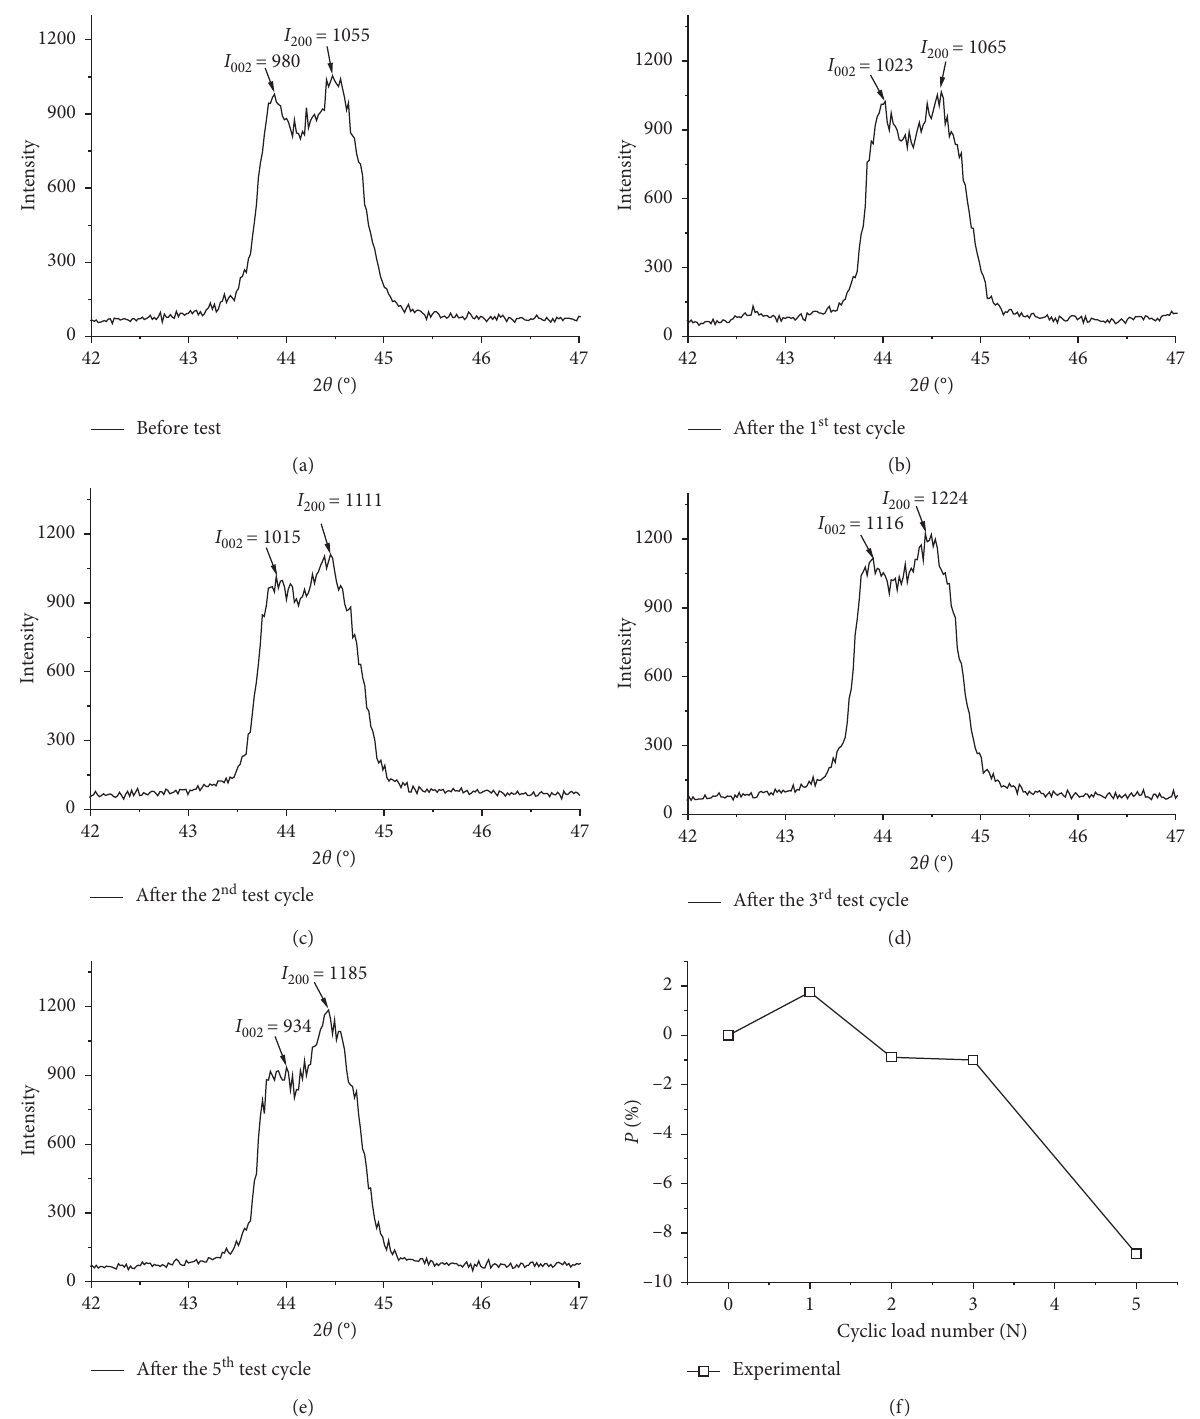
Figure 12: (a) ∼ (e) X-ray diffraction pattern of P51at the cyclic number of 0, 1 st , 2 nd , 3 rd , and 5 th at σ respectively. (f) Percentage of domain switching versus that with cyclic load